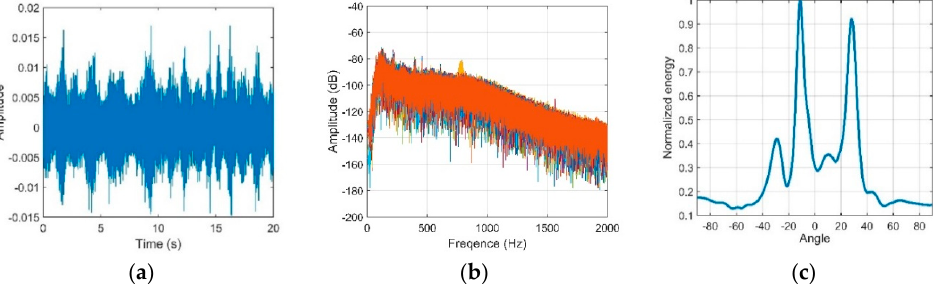
Figure 25. ( a ) Noise waveform; ( b ) Noise frequency through the 100 Hz to 1 kHz bandpass filter; ( c ) Directionality of the noise.